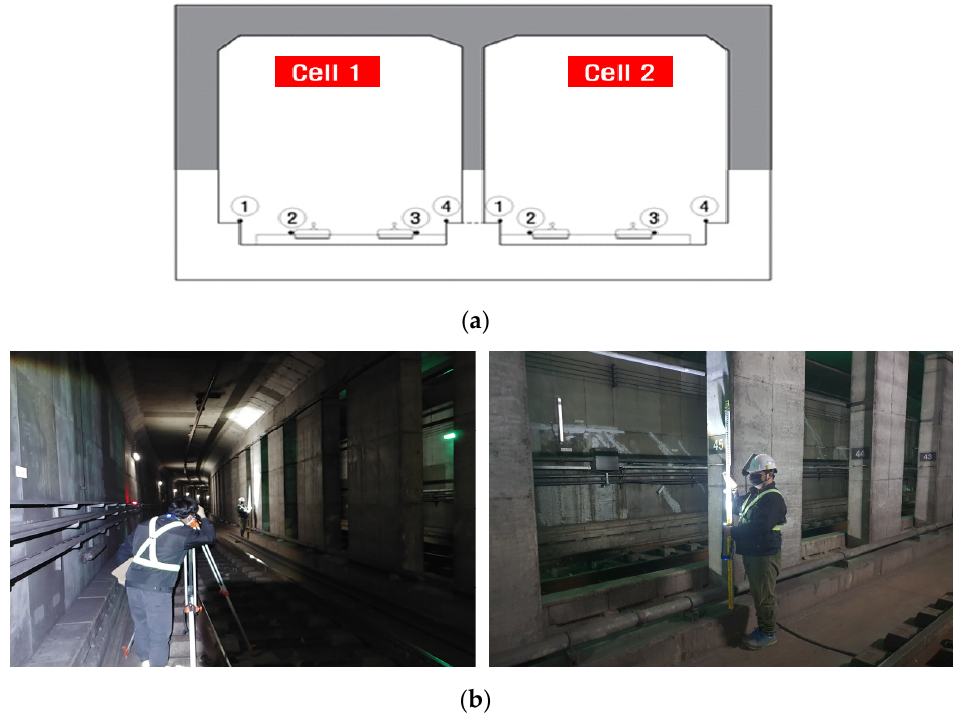
Figure 2. Optical leveling: ( a ) points of optical leveling; ( b ) photographs of optical leveling. Heaving of 0.01–0.02 m occurred in the 25–35 m section, and the maximum deflection of − 0.18 to − 0.186 m occurred in the 60–70 m section (settlement section), as illustrated in Figure 3.